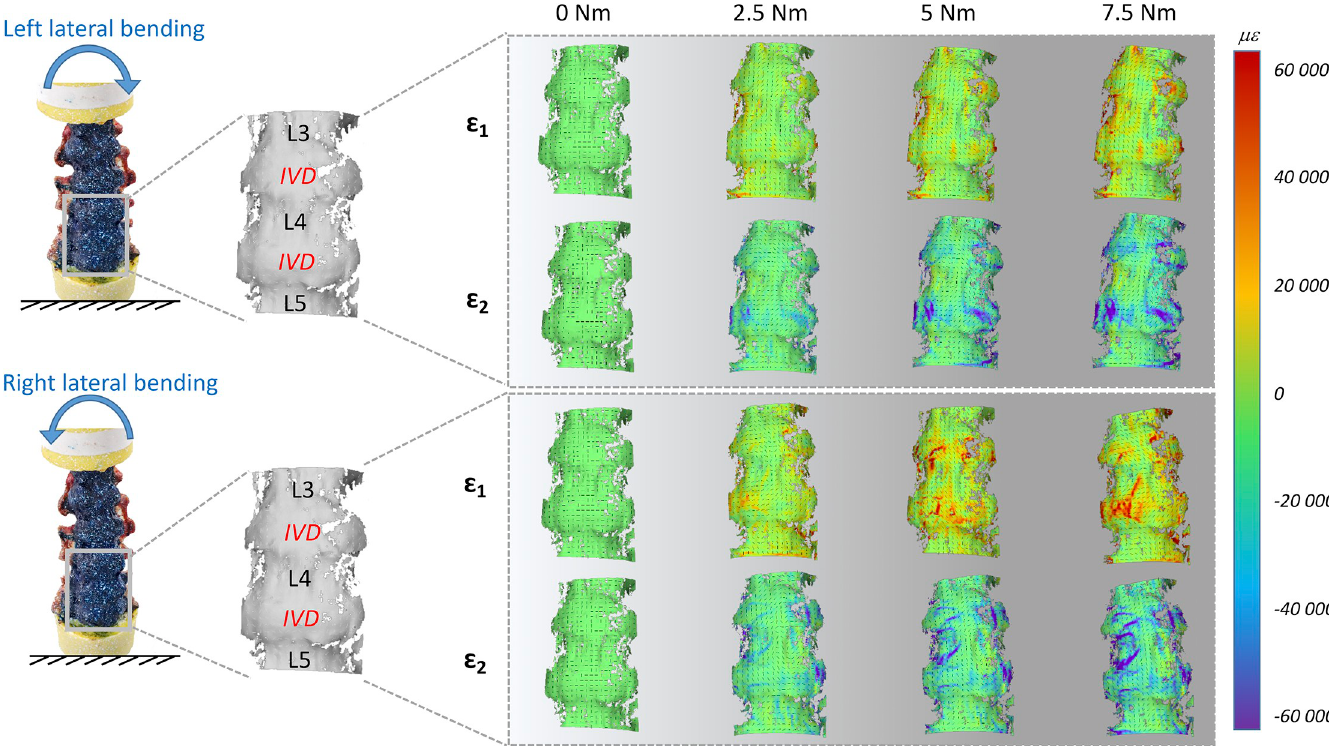
Fig 4. Lateral bending: Maximum (eps 1 ) and minimum (eps 2 ) principal strain fields during the progression of the loading cycle (0.0, 2.5, 5.0, 7.5 Nm) in both opposite directions. The images on the left show the actual specimen under load and the correlated (the vertebrae and IVDs are labelled). The false-colours maps show the non-uniform distribution of strain. The black dashes indicate the principal strain directions. A typical specimen (#2) is shown here. Similar patterns were observed in all 5 specimens (the strain maps for all the individual specimens are reported in the S1 Fig, S1 and S2 Dataset). A movie of the entire loading cycle is available on